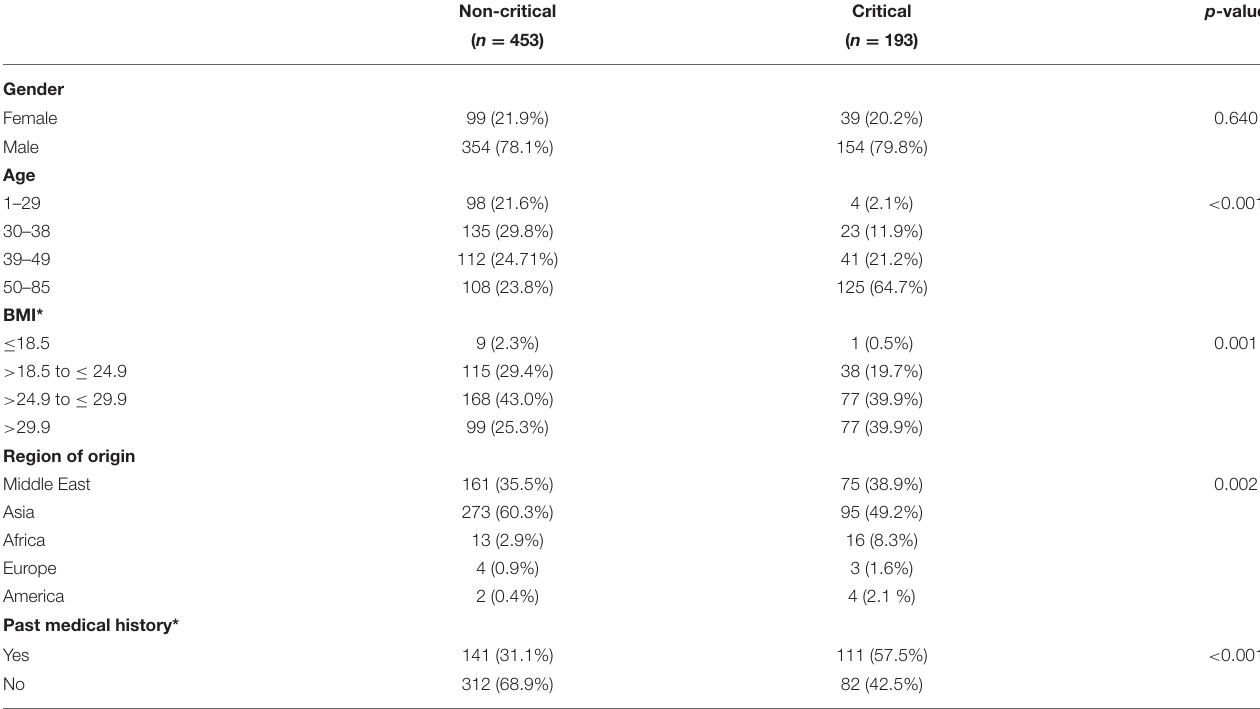
TABLE 1 | Demographic characteristics.